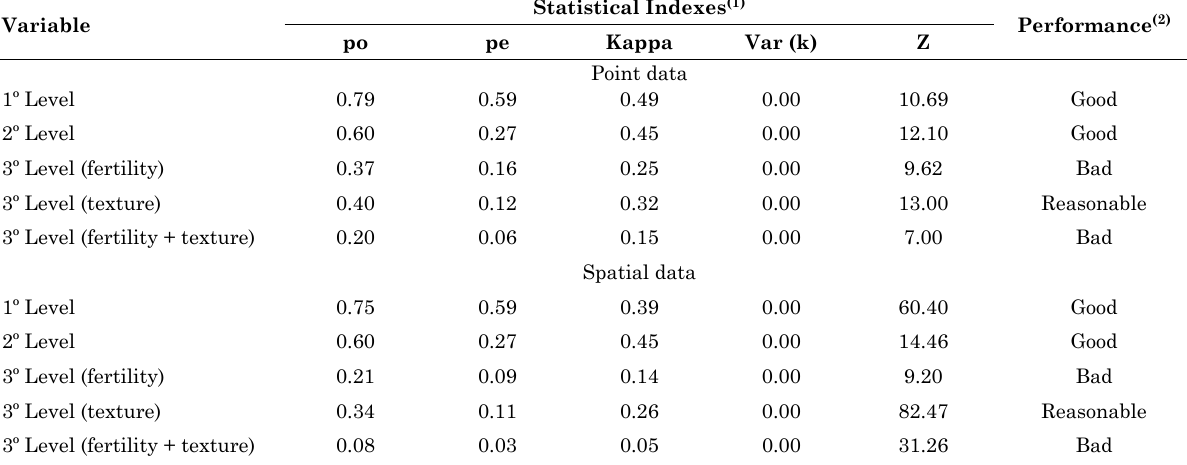
table 5. statistical index derived from the confusion matrix between the point results (boreholes with auger) and spatial results (soil map) obtained by crossing soil taxonomy in the 1 st , 2 nd , and 3 rd levels considering fertility, the 3 rd level considering texture, and the 3 rd level considering fertility plus texture